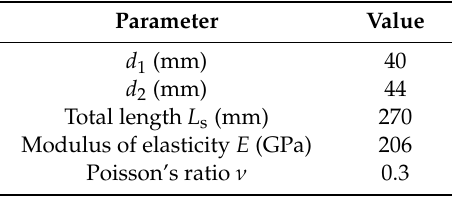
Table 3. The parameters of the